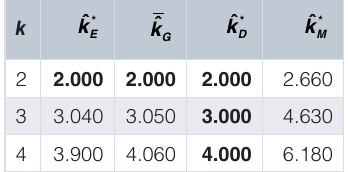
Table 10. Average cluster numbers over n = 200 runs.